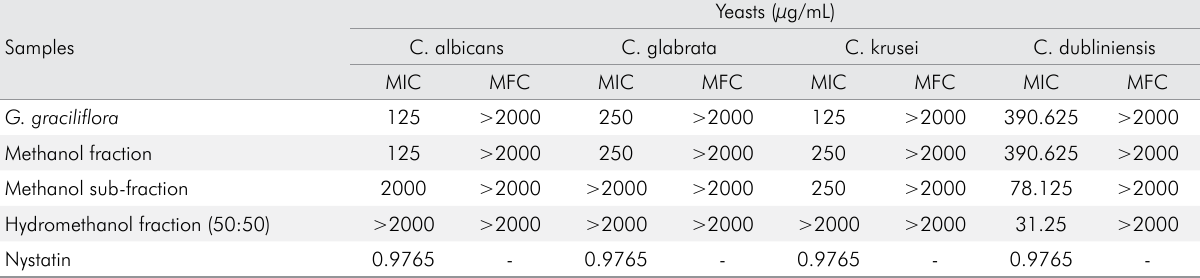
Table 2. Distribution of minimum inhibitory concentration and minimum fungicidal concentration of G. graciliflora extract and fractions according to species of